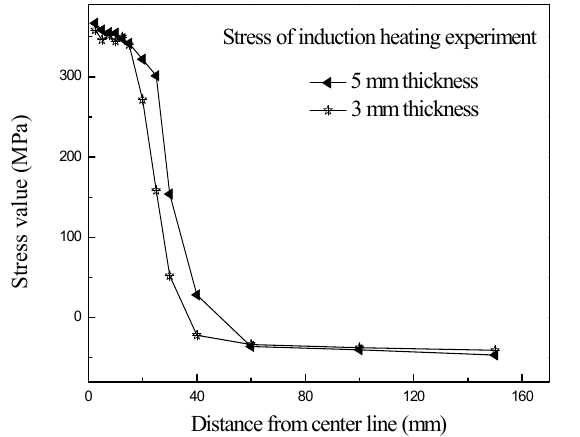
Figure 8. The longitudinal residual stress (y-direction) after induction heating: 3 mm thickness (Plate No. 3) and 5 mm thickness (Plate No. 6).